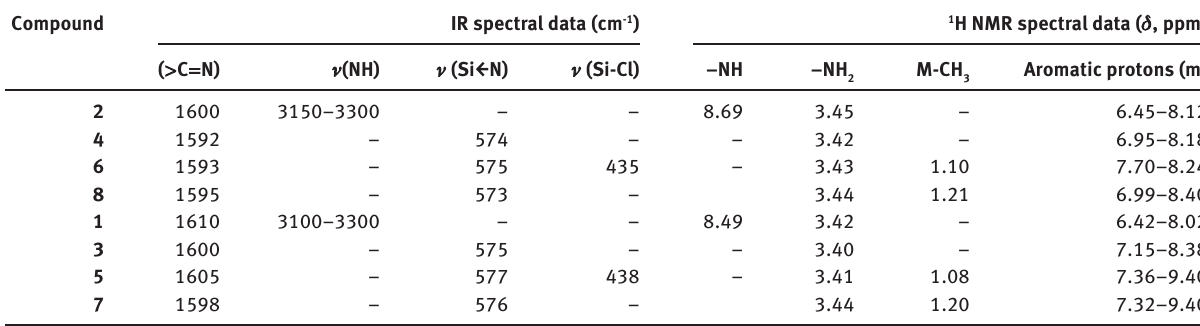
Table 1 IR (cm -1 ) and 1 H NMR ( δ , ppm) spectral data of the ligands and their corresponding complexes. Compound IR spectral data (cm -1